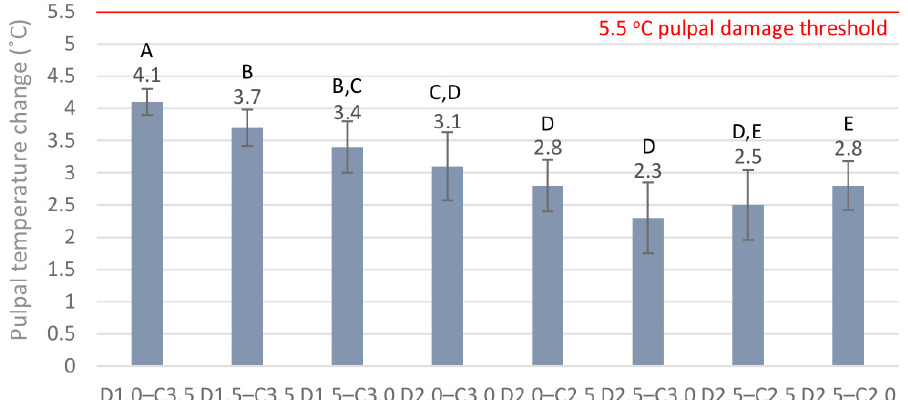
Figure 2. Pulpal temperature changes during light exposure through eight different combinations of dentin (D1.0, 1 mm; D1.5, 1.5 mm; D2.0, 2.0 mm; D2.5, 2.5 mm) and ceramic thicknesses (C2.0, 2.0 mm; C2.5, 2.5 mm; C3.0, 3.0 mm; C3.5, 3.5 mm) without luting cement. Different capital letters (A–